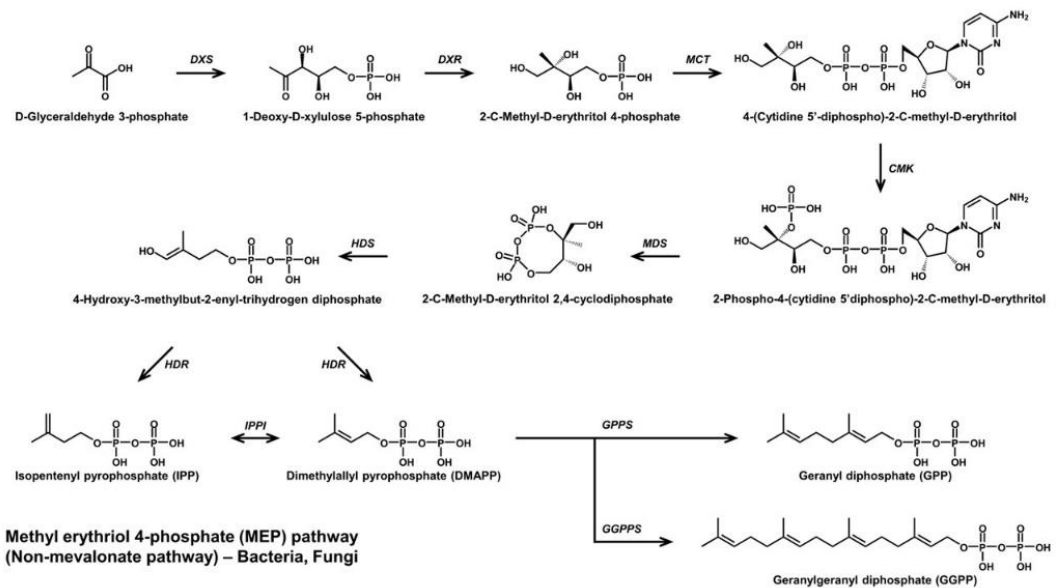
Figure 2. Methyl erythritol 4-phosphate (MEP) pathway as taken by bacteria and fungi. DXS: Deoxyxylulose 5-phosphate synthase. DXR: Deoxyxylulose 5-phosphate reductoisomerase. MCT: 2-C-methyl-d-erythritol 4-phosphate cytidylyltransferase. CMK: 4-diphosphocytidyl-2-C-methyl-D- erythritol kinase. MDS: 2-C-methyl-d-erythritol 2,4-cyclodiphosphate synthase. HDS: 4-hydroxy-3- methylbut-2-en-1-yl diphosphate synthase. HDR: (E)-4-hydroxy-3-methylbut-2-enyl diphosphate reductase. IPPI: Isopentenyl diphosphate isomerase. GPPS: Geranyl diphosphate synthase. GGPPS: Geranylgeranyl diphosphate